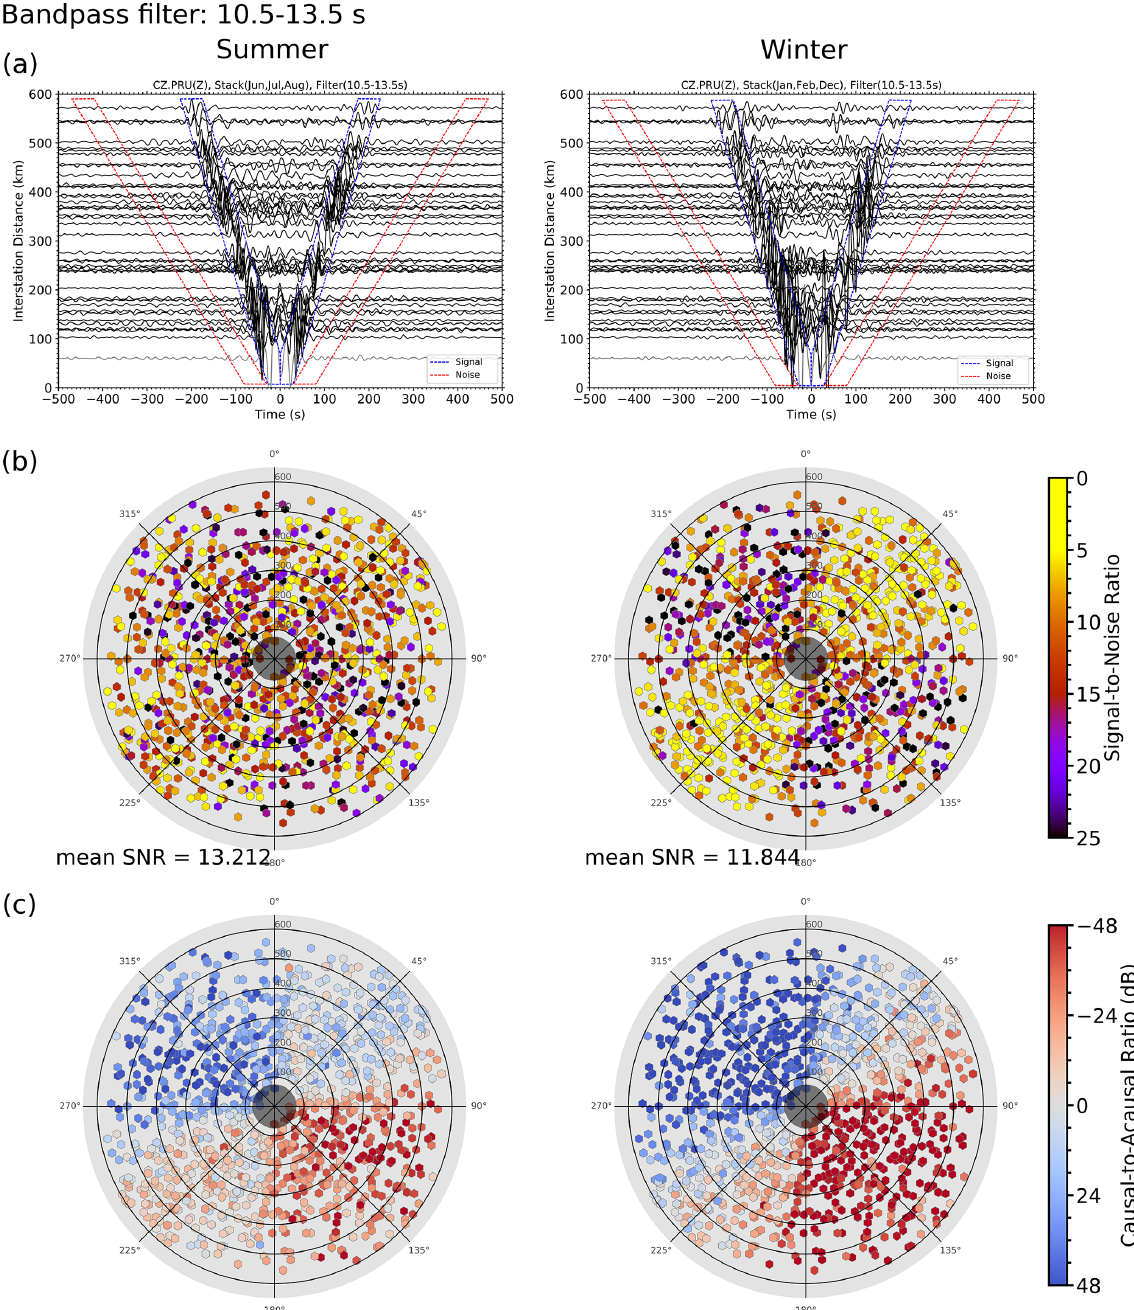
Figure 3. Examples of cross-correlation functions (a) between data from station CZ.PRU and all permanent stations for the summer (left) and winter (right) months. The blue lines delimit windows used to measure the root mean square (RMS) amplitude of the coherent signal, and the red lines delimit windows used to measure the RMS amplitude of the non-coherent noise. Azimuth–inter-station distance rose diagrams present the signal-to-noise ratio (b) and the source directivity calculated as ratios of the causal and acausal parts of the CCF signals (c) for all permanent stations in the region for the winter and summer months (left and right diagrams respectively). The 10.5–13.5s bandpass filter was applied before the analysis (Figs. S1–S5 present the same analyses with different bandpass filters). The CCFs and measurements in the rose diagrams that do not satisfy the minimal separation condition of the station pair for each period band are shown using grey and coloured shading